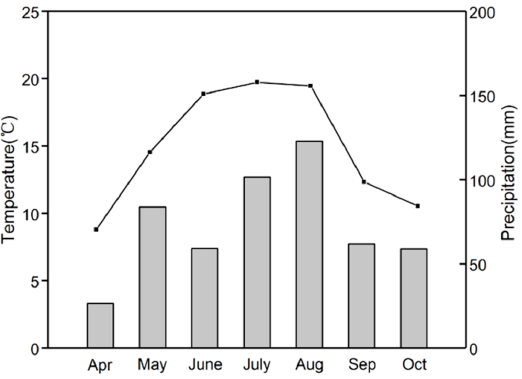
Figure 2. Monthly totals of precipitation (mm; bar graph) and monthly average temperature ( °C ; dotted line) for the study site from April to October 2017. ( ◦ C; dotted line) for the study site from April to October